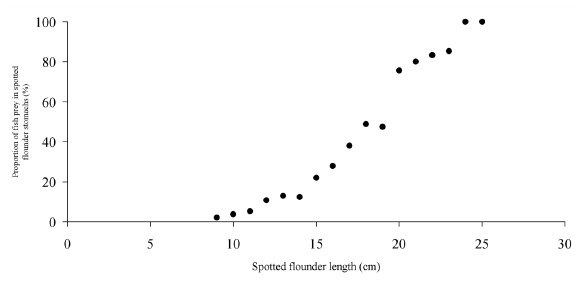
Fig . 5. – Proportion (%) in number of fish prey occurring in the diet of Citharus linguatula during its growth.